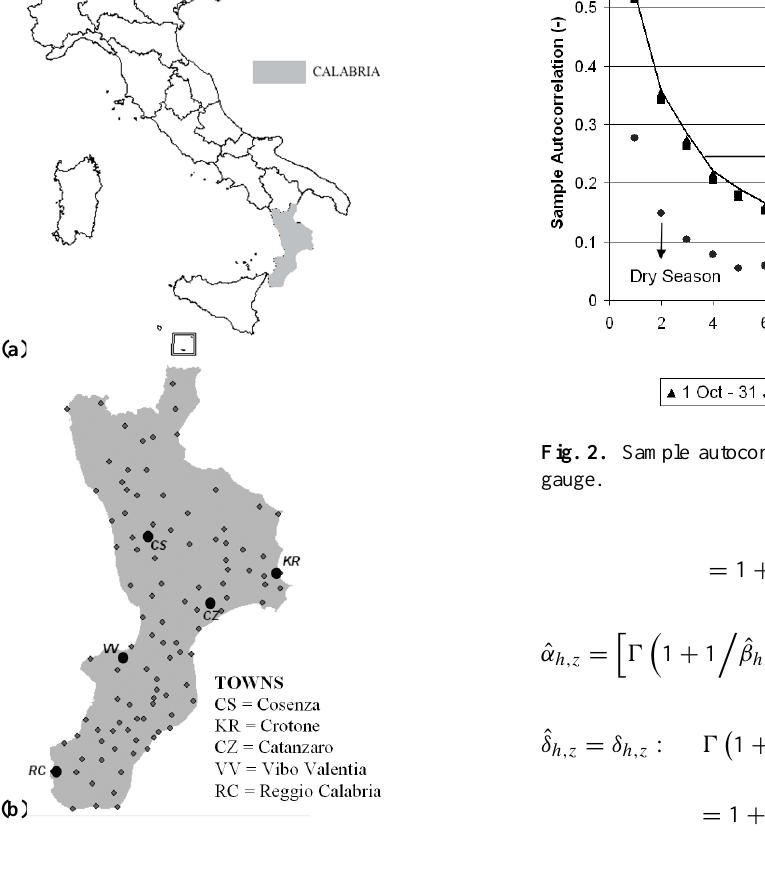
Fig. 1. (a) Location of the Calabria region, in the Southern Italy; (b) Telemetering Raingauge Network.